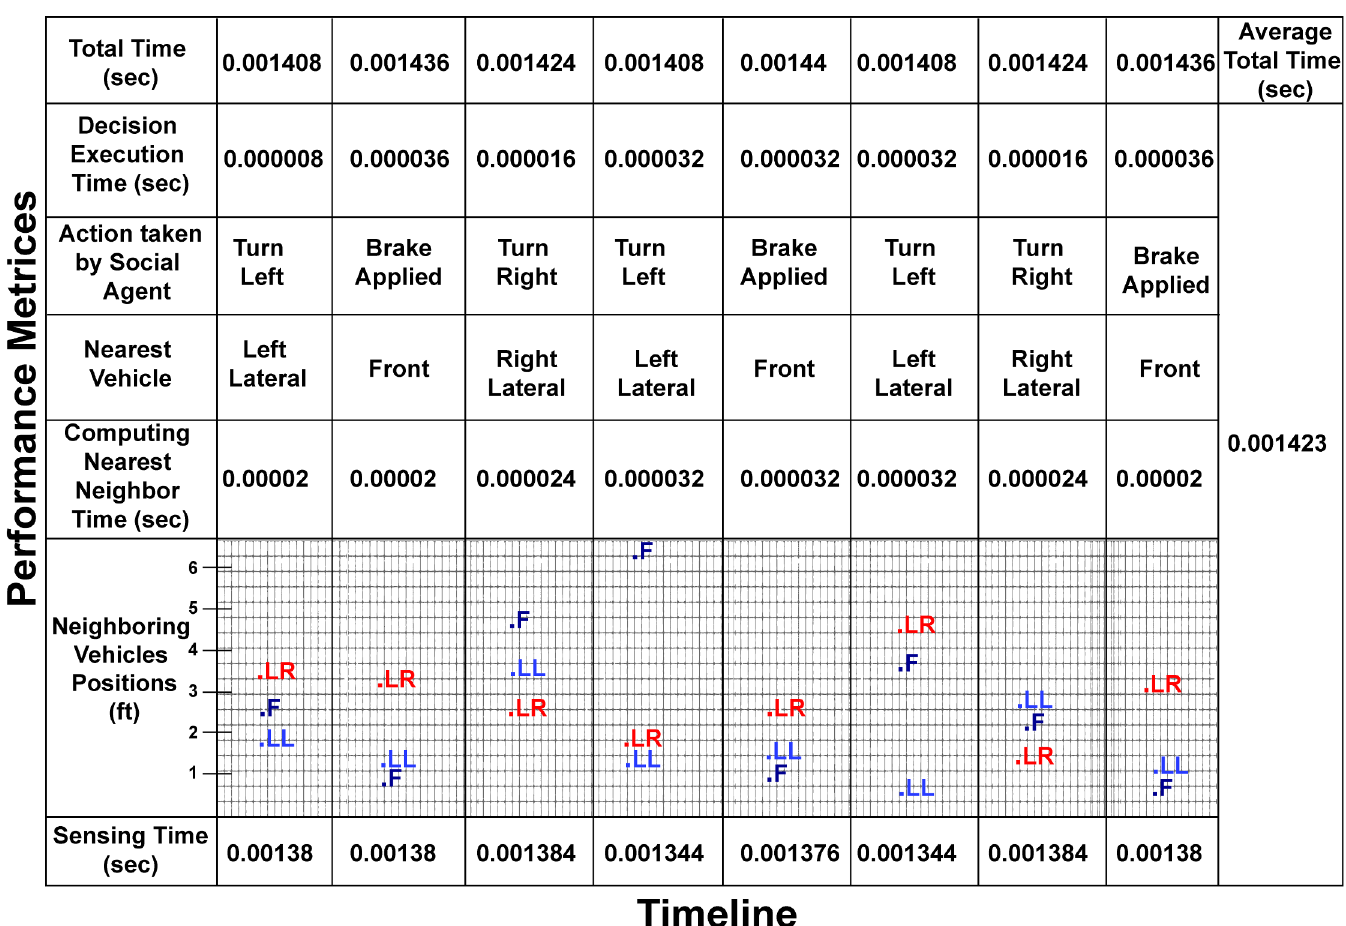
Fig 11. Results of in field experiments in terms of time taken by the social agent for the collision avoidance in the flock like topology.